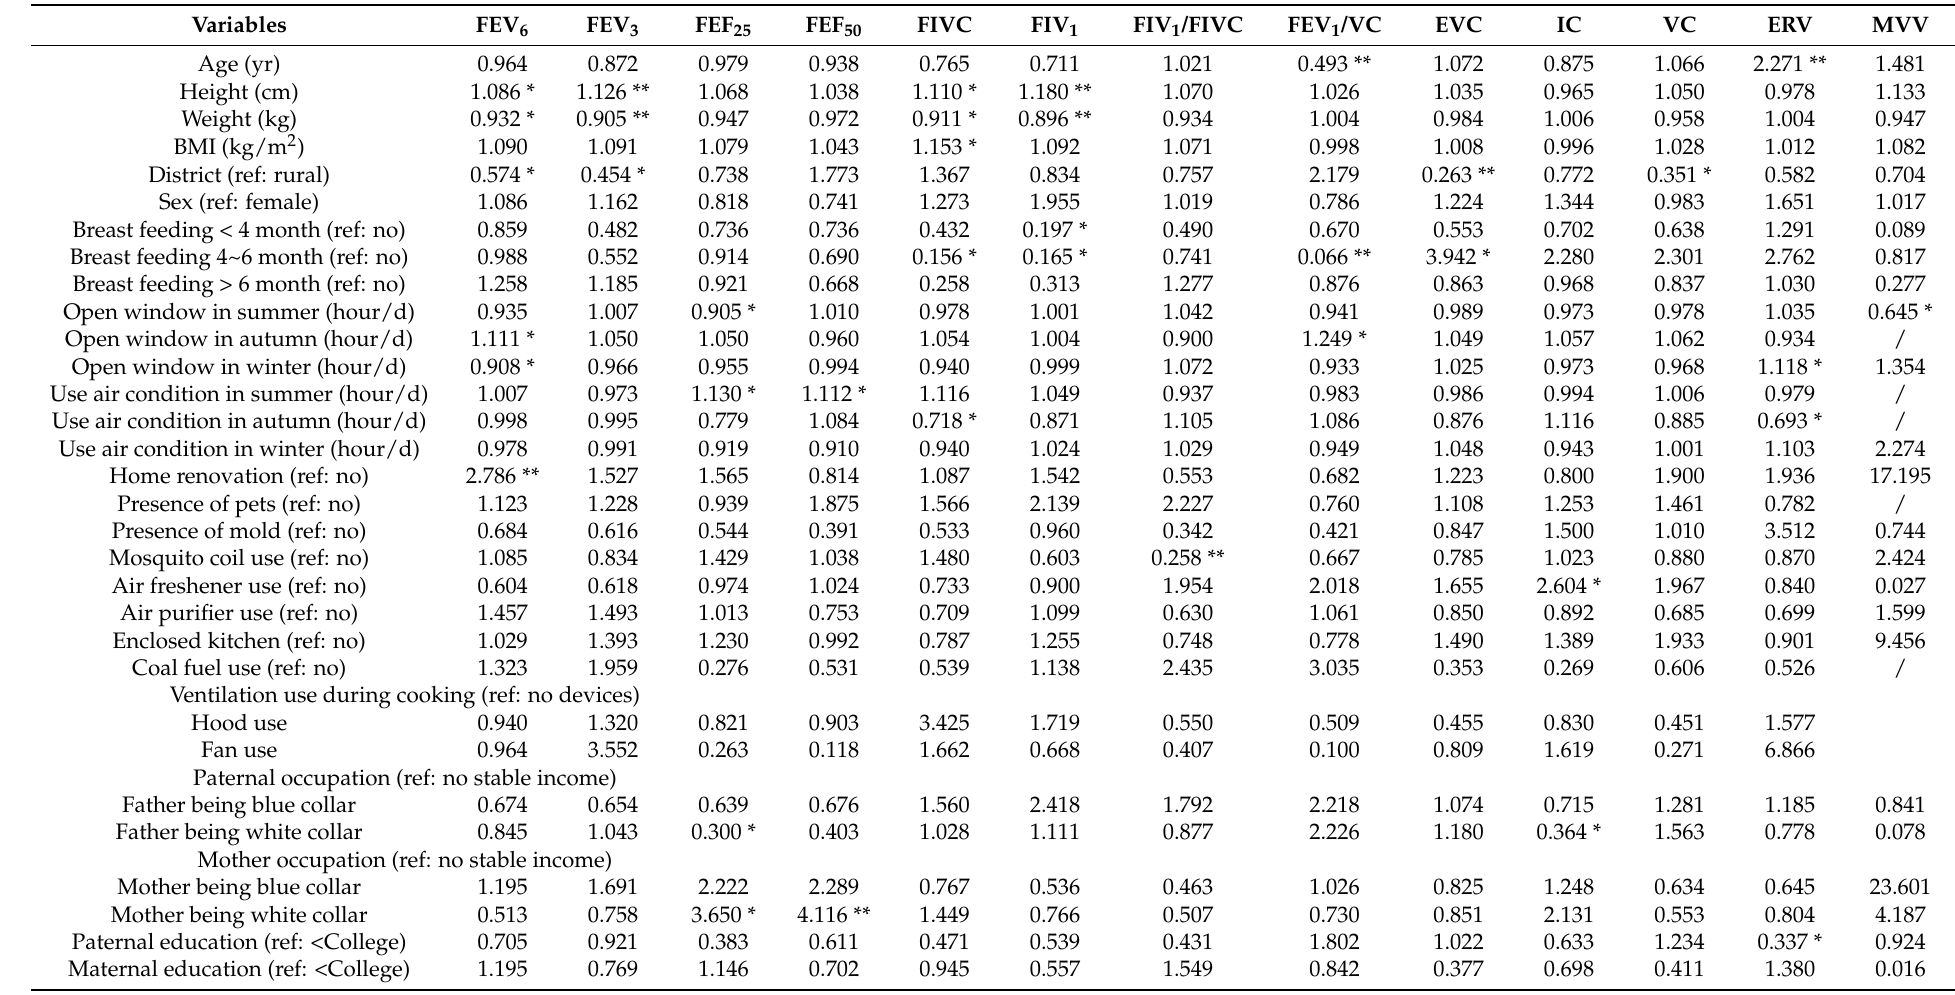
Table 4. Adjusted odds ratios (OR) of impaired lung function in relation to socioeconomic, personal behavior pattern, parental, and household factors in children 1 .